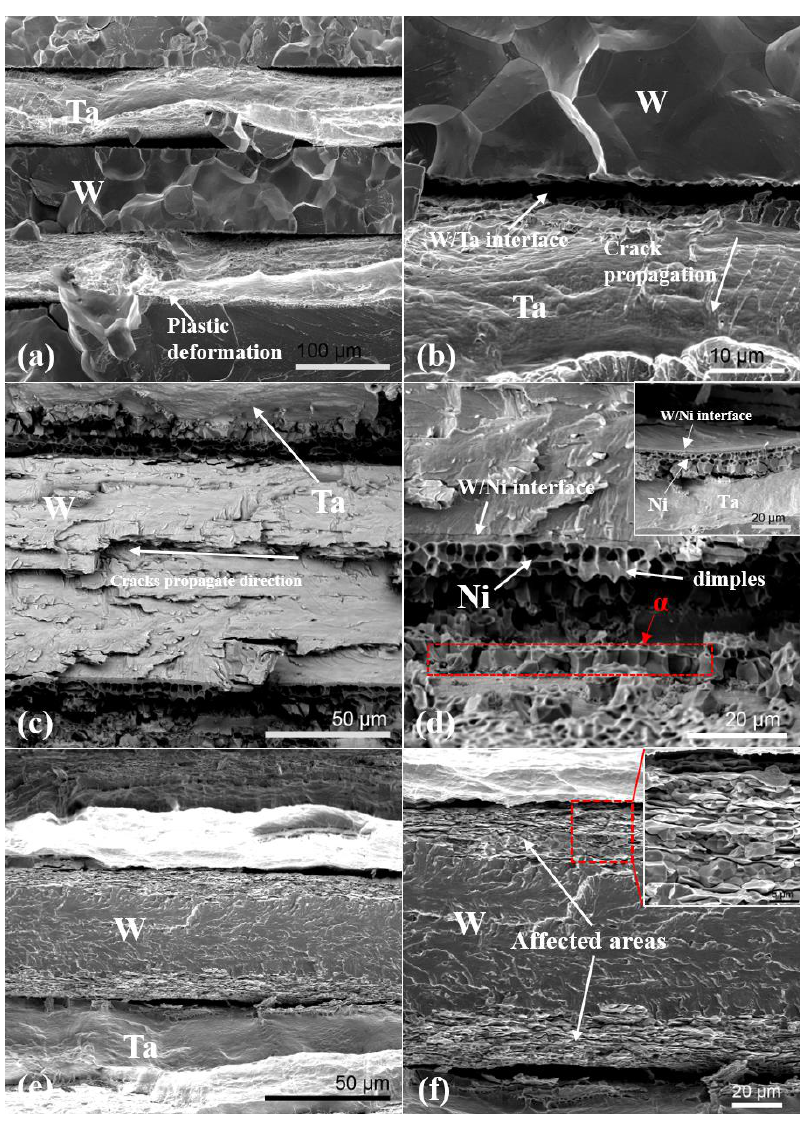
Figure 4. Tensile fracture morphology of (a)(b)W/Ta, (c)(d)W/Ni/Ta and (e)(f)W/Ti/Ta